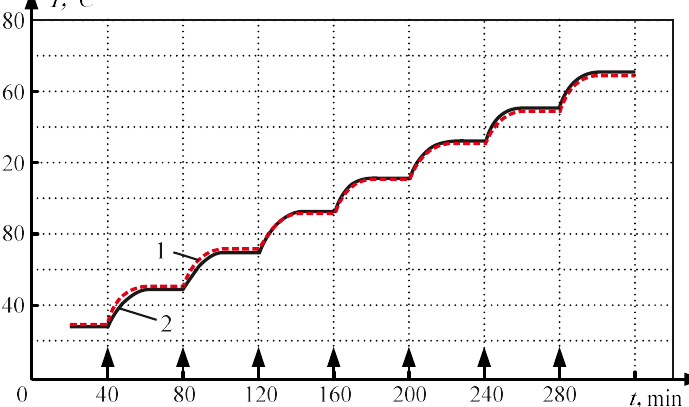
Figure 9. The results of measuring the temperature of the stator windings of the base (1) and tested (2) electric motors.